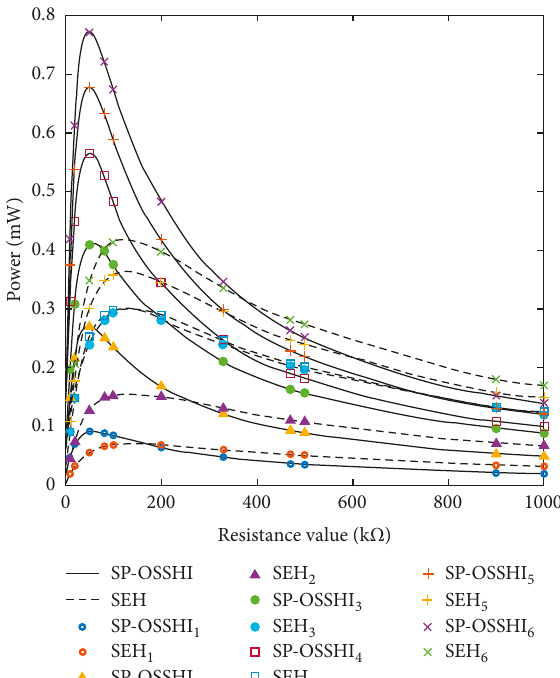
Figure 13: Various excitation circuit experiment